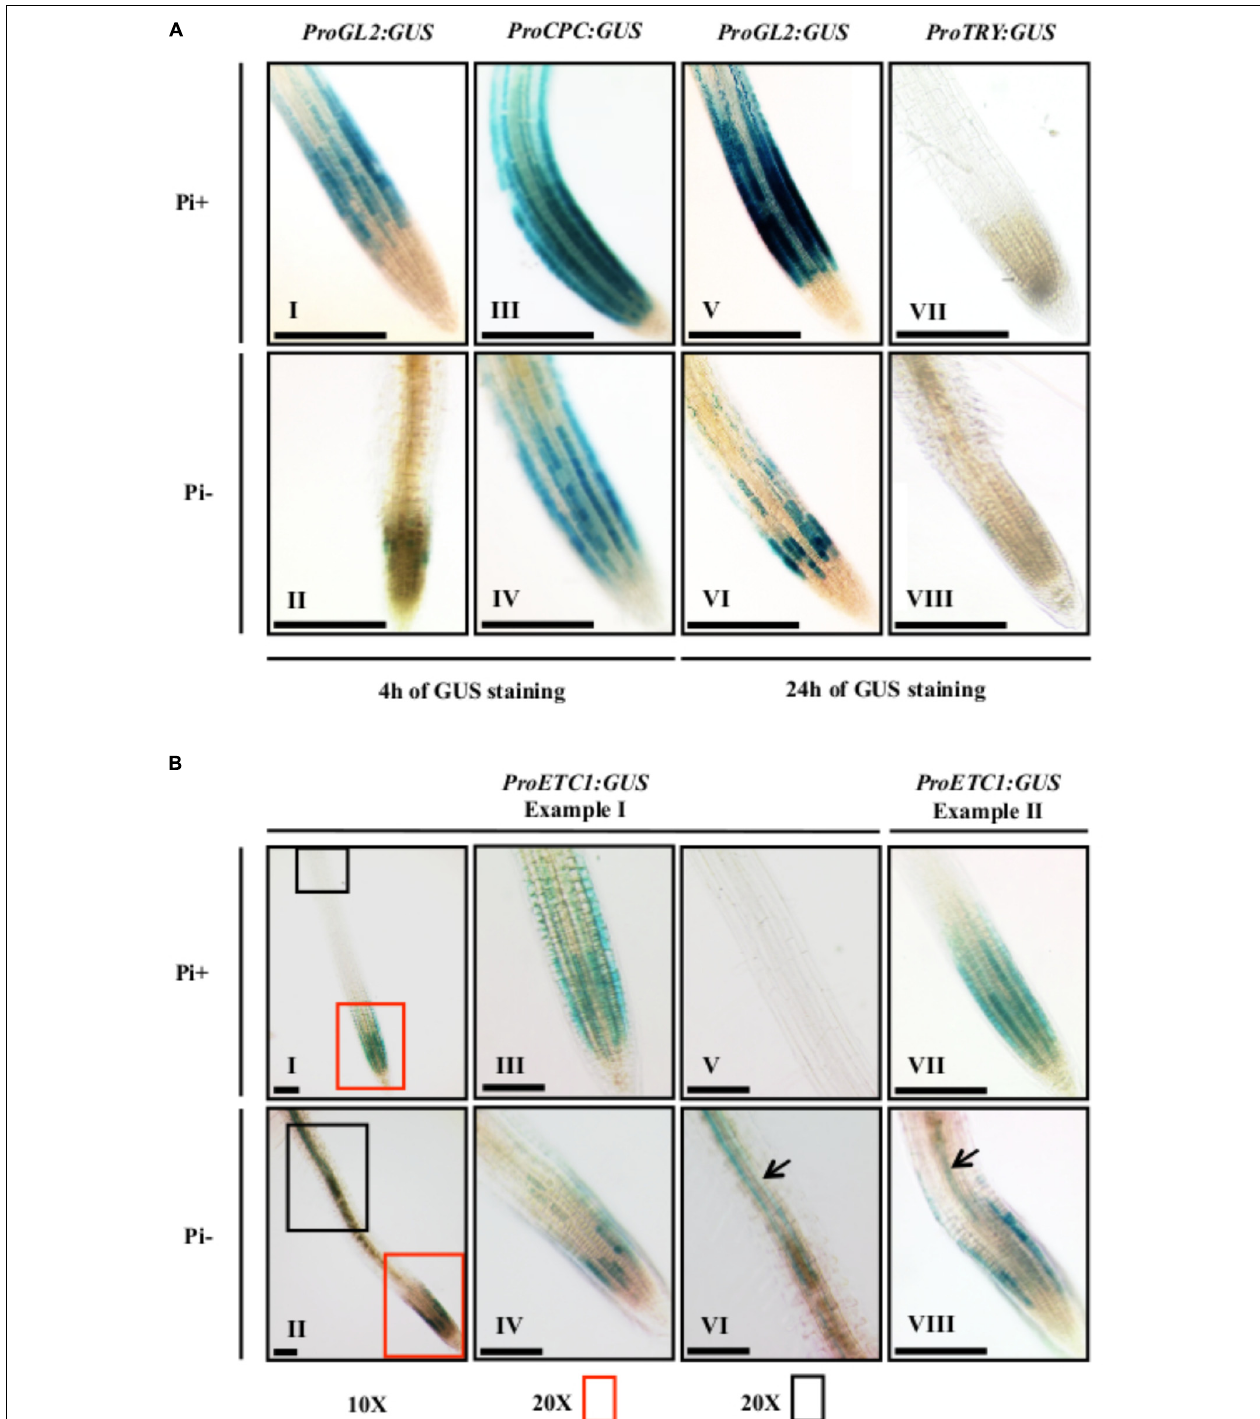
FIGURE 2 | Histochemical GUS expression analysis of Pro CPC , Pro GL2, Pro TRY, and Pro ETC1. GUS expression staining was done on 7-day old seedlings grown on Pi+ media and Pi– media. (A) GUS expression of Pro CPC , ProGL2 , and Pro TRY. GUS staining was done for 4 h in seedlings (I–IV) and for 24 h in seedlings (V–VIII). A reduction in GUS expression was noticed for Pro GL2 and Pro CPC in seedlings grown under Pi– conditions (II, IV, VI) as compared to seedlings grown on Pi+ (I, III, V). No GUS expression was detected for Pro TRY under both Pi+ and Pi– conditions (VII, VIII). (B) GUS expression of Pro ETC1 . Two examples are shown to depict the variability of the expression pattern. Plant I (I, II) shows an overview and higher magnifications of the root tip (III, IV) and a more distal region (V, VI). A new expression domain of Pro ETC1 was found in the sub-epidermis under Pi– conditions (black arrows in VI and VIII). Scale bars: 200 µ m.